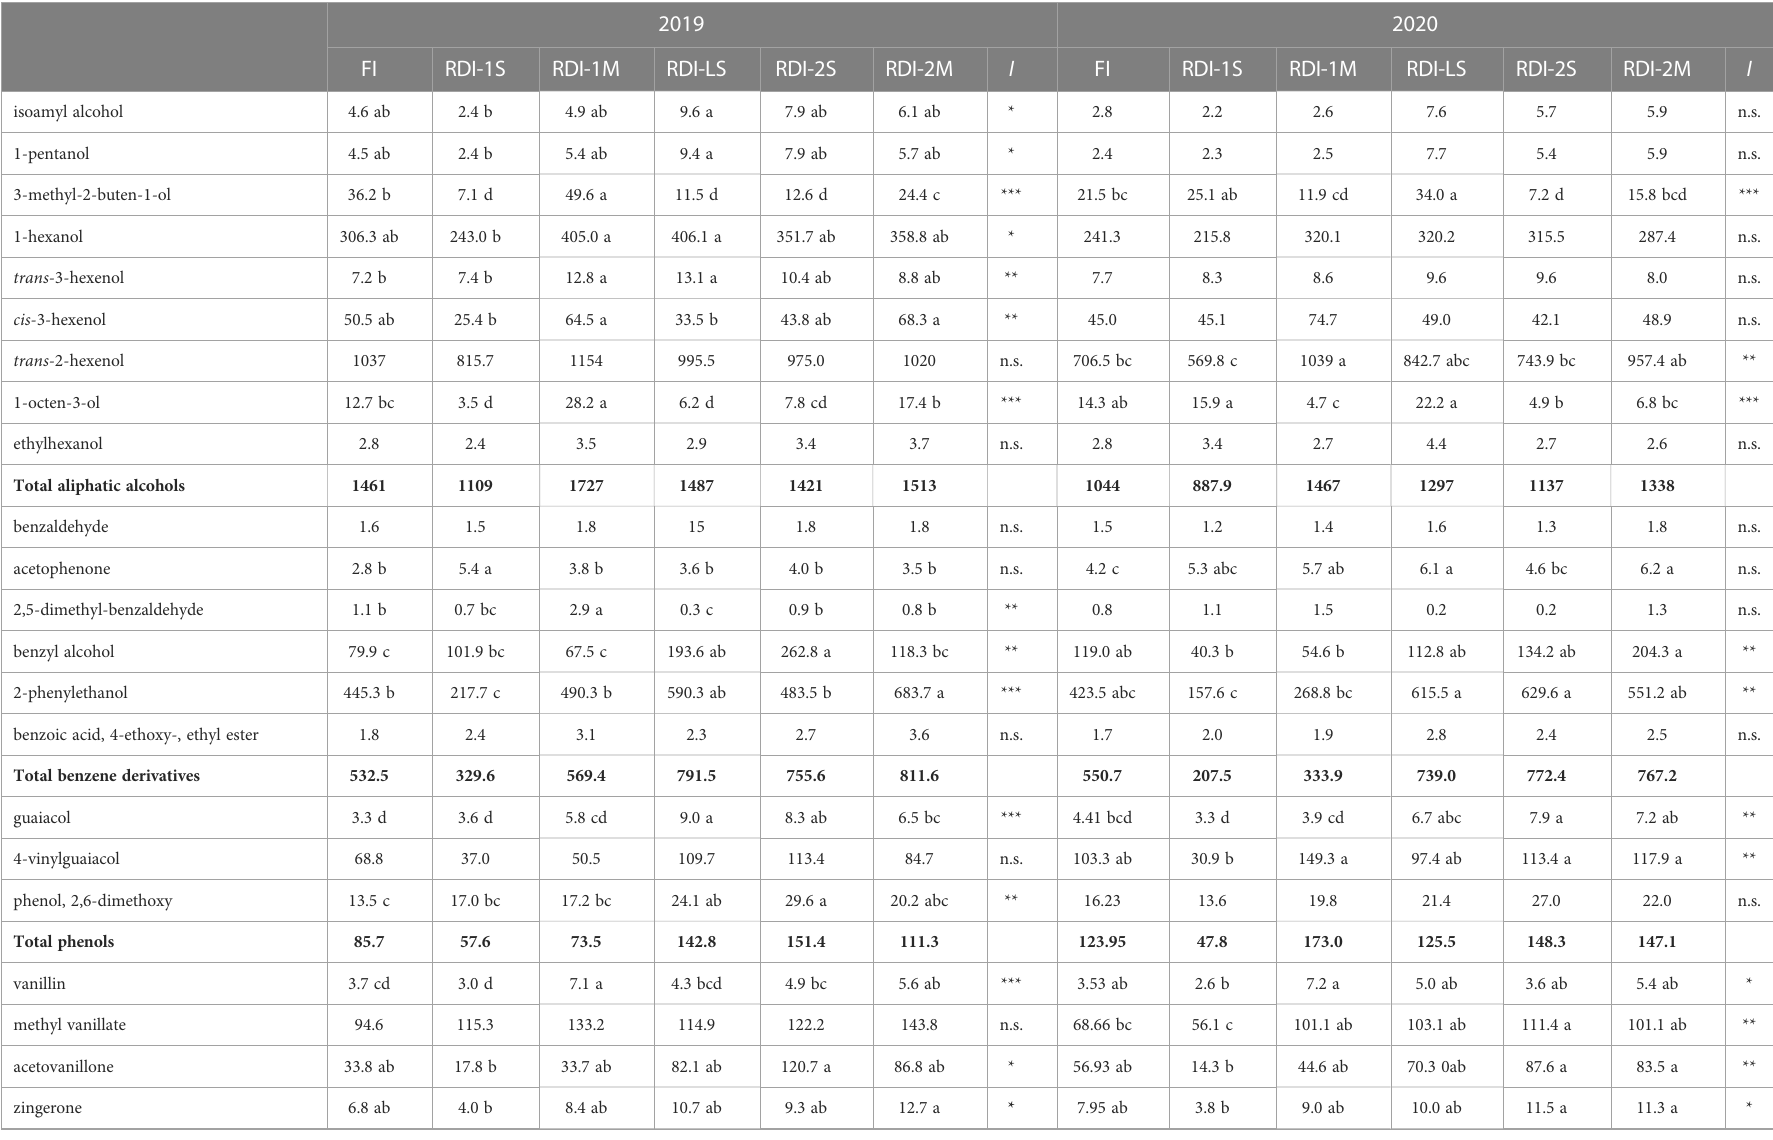
TABLE 2 Free VOCs measured at harvest in berries of Sangiovese grapevines ( Vitis vinifera L.) subjected to six irrigation regimes (FI, full irrigation from berry pea size to harvest; RDI-1S and RDI-1M, severe and moderate water de fi cit applied from berry pea size to veraison; RDI-LS, water de fi cit applied during lag phase; RDI-2S and RDI-2M, severe and moderate water de fi cit applied from veraison to harvest) in 2019